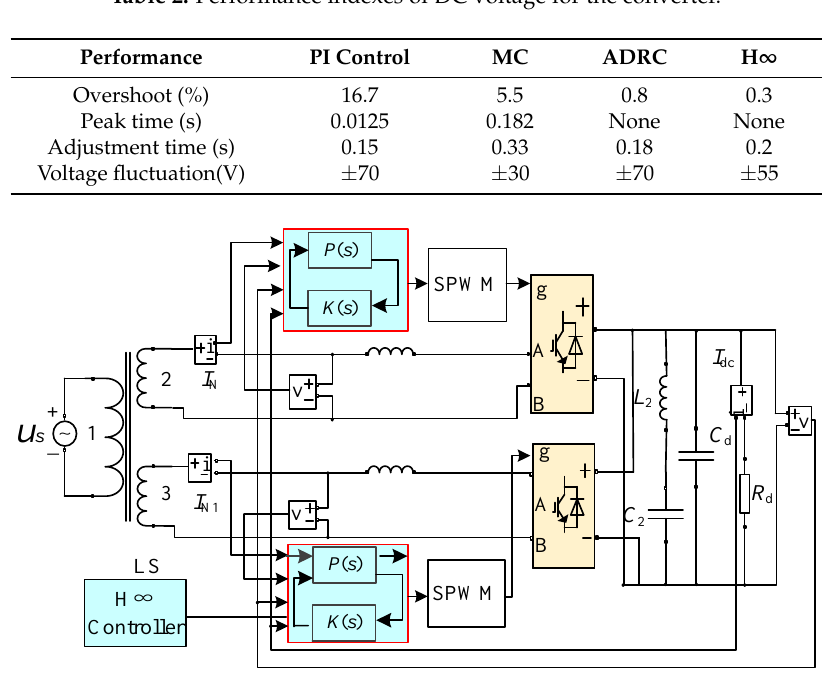
Figure 6. Simulation model of the twofold four-quadrant EMUs converter.